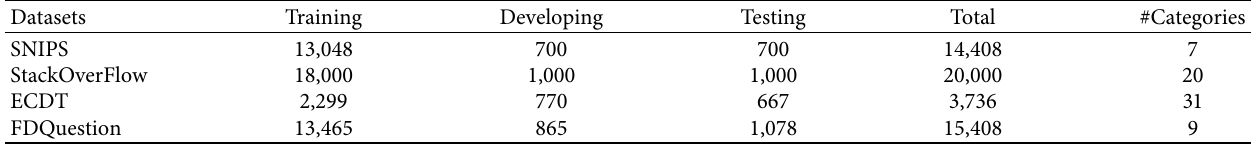
Table 1: The statistics of the four datasets.